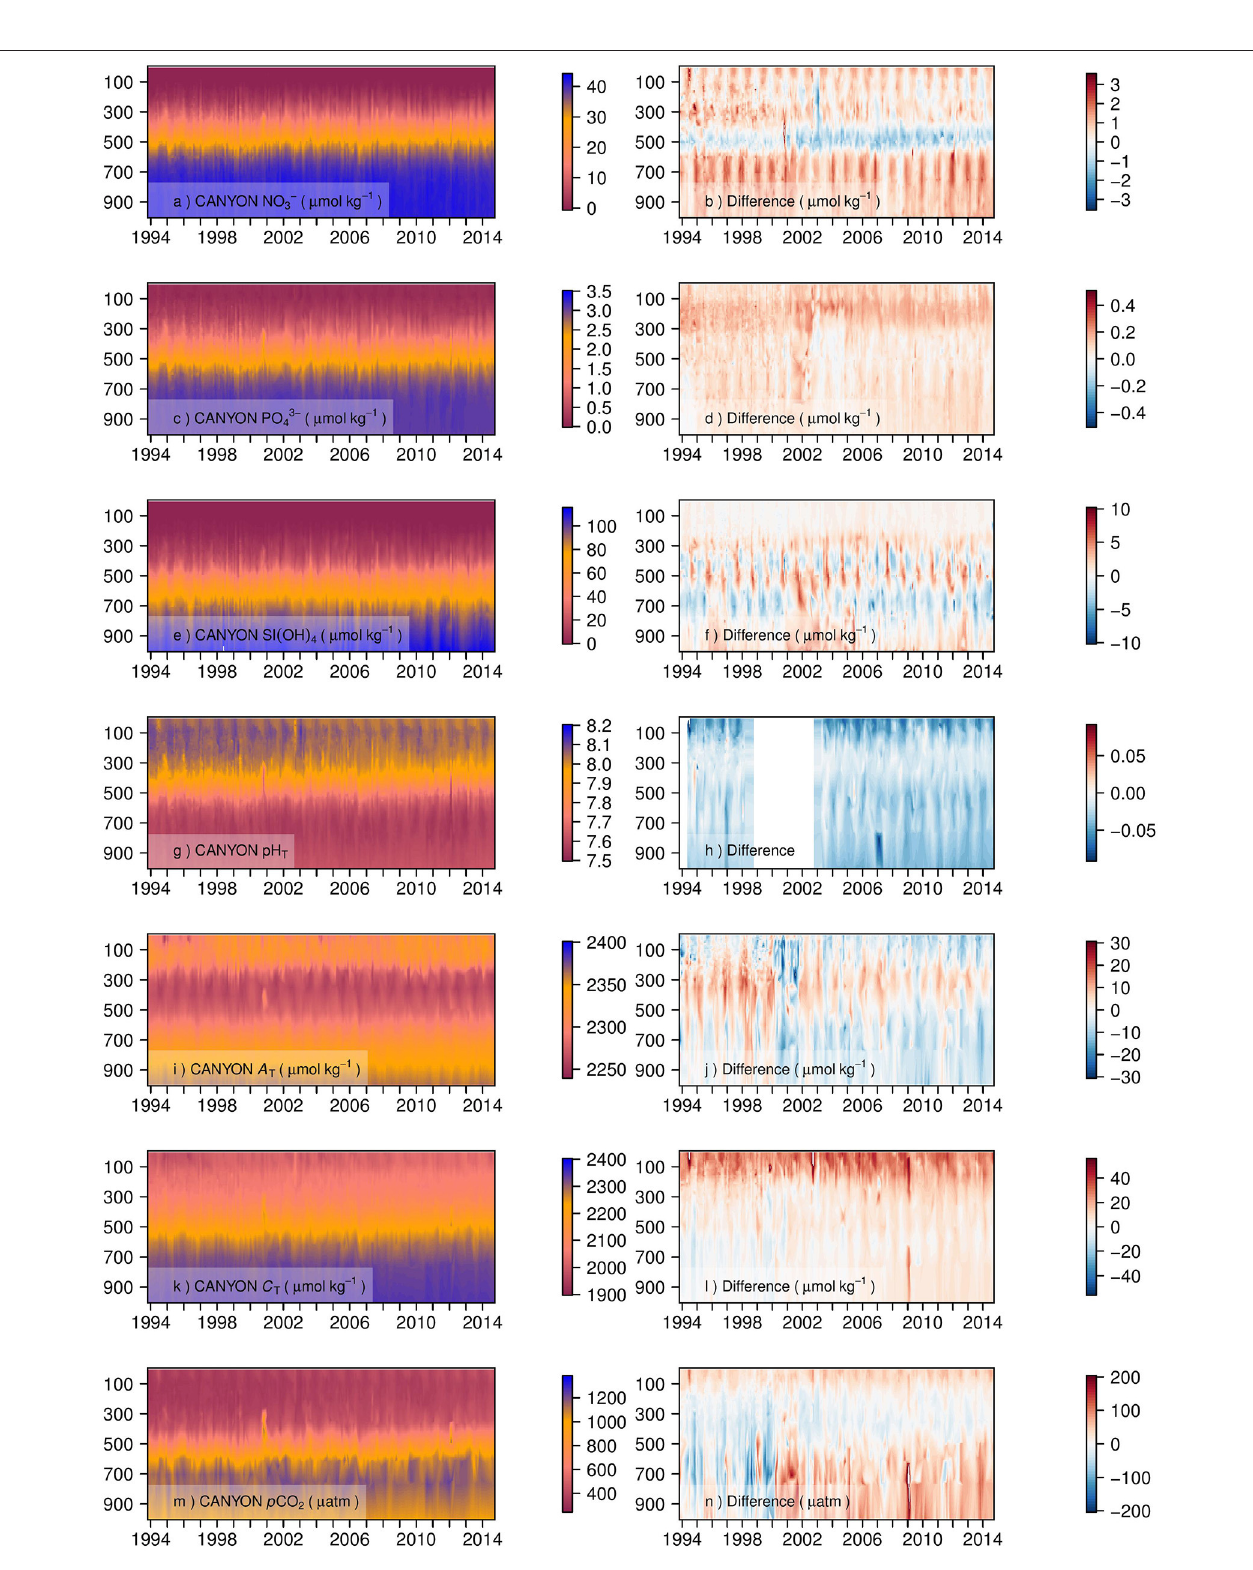
FIGURE 7 | Values predicted by CANYON (a,c,e,g,i,k,m) and absolute differences between HOT measurements and CANYON estimates (b,d,f,h,j,l,n) . Time series (22 years) for NO 3 − (a,b) , PO 43 − (c,d) , Si(OH) 4 (e,f) , pH T (g,h) , A T (i,j) , C T (k,l) , and p CO 2 (m,n) . Five profiles from 25 February 2003 to 29 March 2003 have been removed from the time-series because of their abnormal O 2 profiles (see details in Section Example of Application: Illustration with HOT Database).